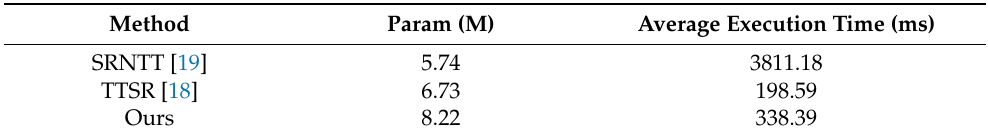
Table 5. Comparison of the number of network parameters and execution time. The methods used for comparison are all patch-based RefSR